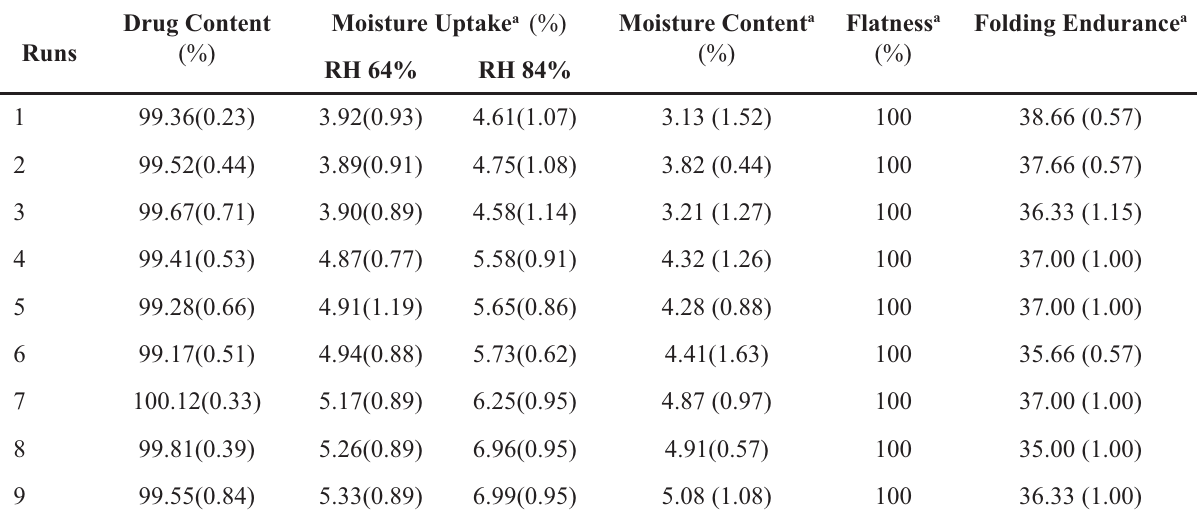
a Data shown are mean of three determinations and figure in the parentheses indicates standard